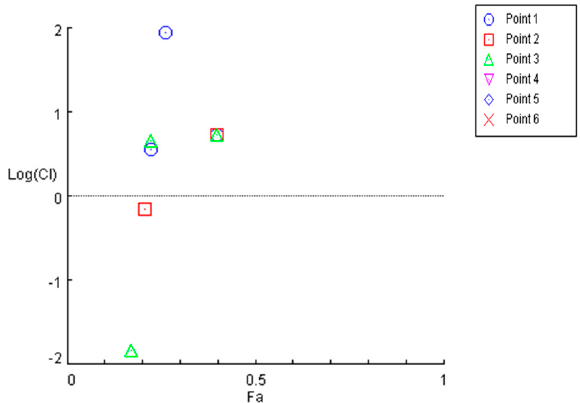
Figure 2. Non-constant drug ratio logarithmic combination index plot of doxorubicin and HAA 2021 calculated using CompuSyn software. X-axis: Fraction affected (Fa: 0.5), y-axis: Log of combination index (CI). The six points in the legend corresponds with the CI values in Table 2. Green triangles: Combination of doxorubicin and 0.25 μ M of HAA 2021 . Red rectangles: Combination of doxorubicin and 0.50 μ M of HAA 2021 . Blue circles: Combination of doxorubicin and 1.00 μ M of HAA 2021 . Plots are results of absorbance generated in three independent experiments ( n = 3). CI > 1.1: Antagonism; CI = 0.9–1.1: Additive; CI = 0.8–0.9: Slight synergism; CI = 0.6–0.8: Moderate synergism; CI = 0.4–0.6: